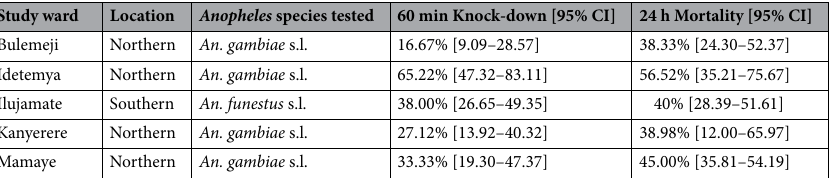
Table 6. Average 60-min knock-down and 24-h mortality to the diagnostic dose of permethrin (WHO tube bioassays: 0.75%), among wild Anopheles species, collected from five study wards in Misungwi, 2018.